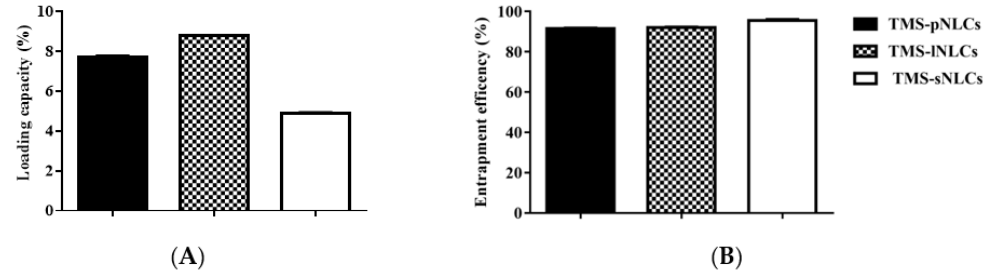
Figure 3. Entrapment efficiency ( A ) and loading capacity ( B ) of the newly prepared TMS ‐ pNLCs, TMS ‐ lNLCs, and TMS ‐ sNLCs.